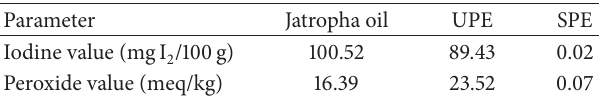
Table 1: Iodine and peroxide test data for Jatropha oil, UPE, and